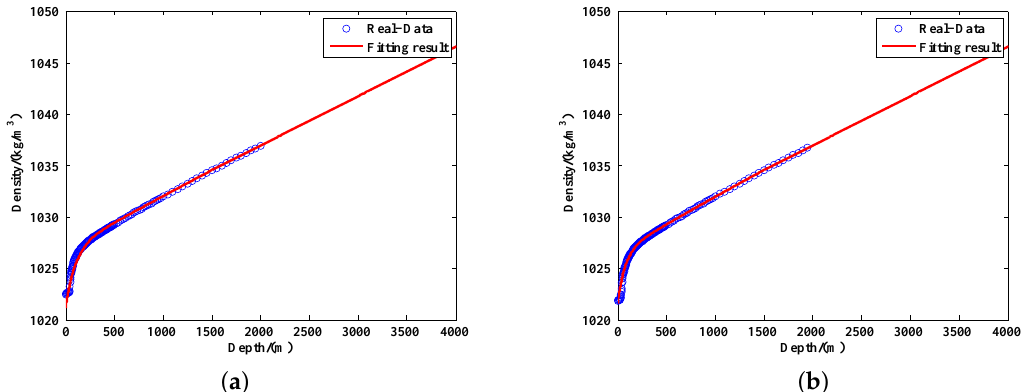
Figure 6. The fitting result of the density data in the equator area. Panel ( a ) shows the seawater’s density data in summer and ( b ) shows the seawater’s density data in winter.